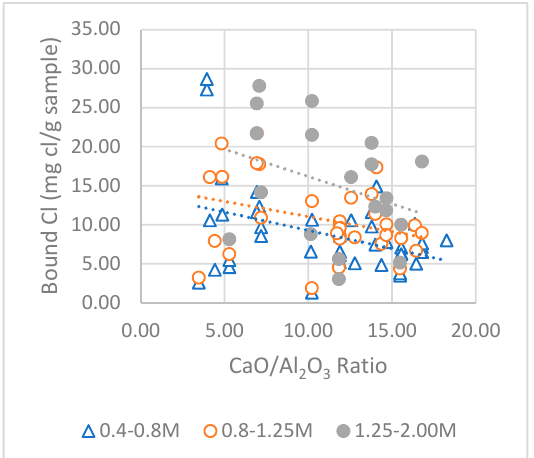
Figure 13. Relation between CaO/Al 2 O 3 ratio and bound chloride for different chloride concentra- tions for all data.